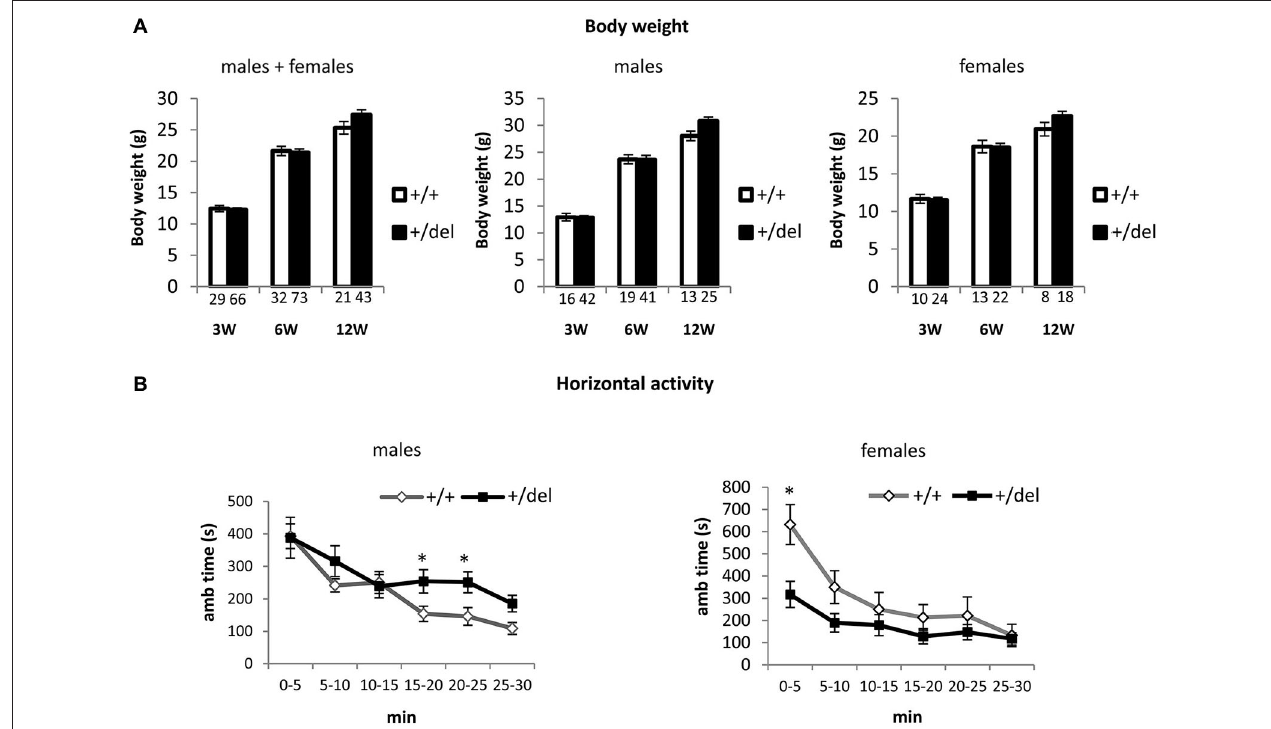
graphs. (B) Horizontal activity was measured as ambulatory time in the open field over a 30 min trial divided in 5 min blocks. Males showed hyperactivity in the last part of the experimental time (left panel; n + / + = 10, n + / del = 12) by contrast females showed hypoactivity (right panel ; n +/+ = 5, n +/del = 7). * p <